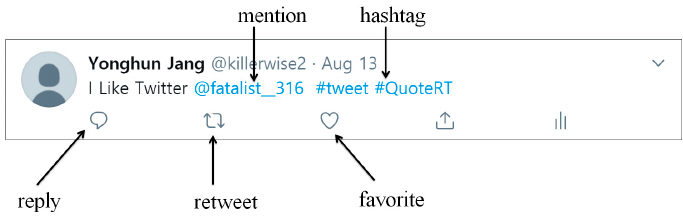
Figure 2. A Tweet and major features of Twitter.